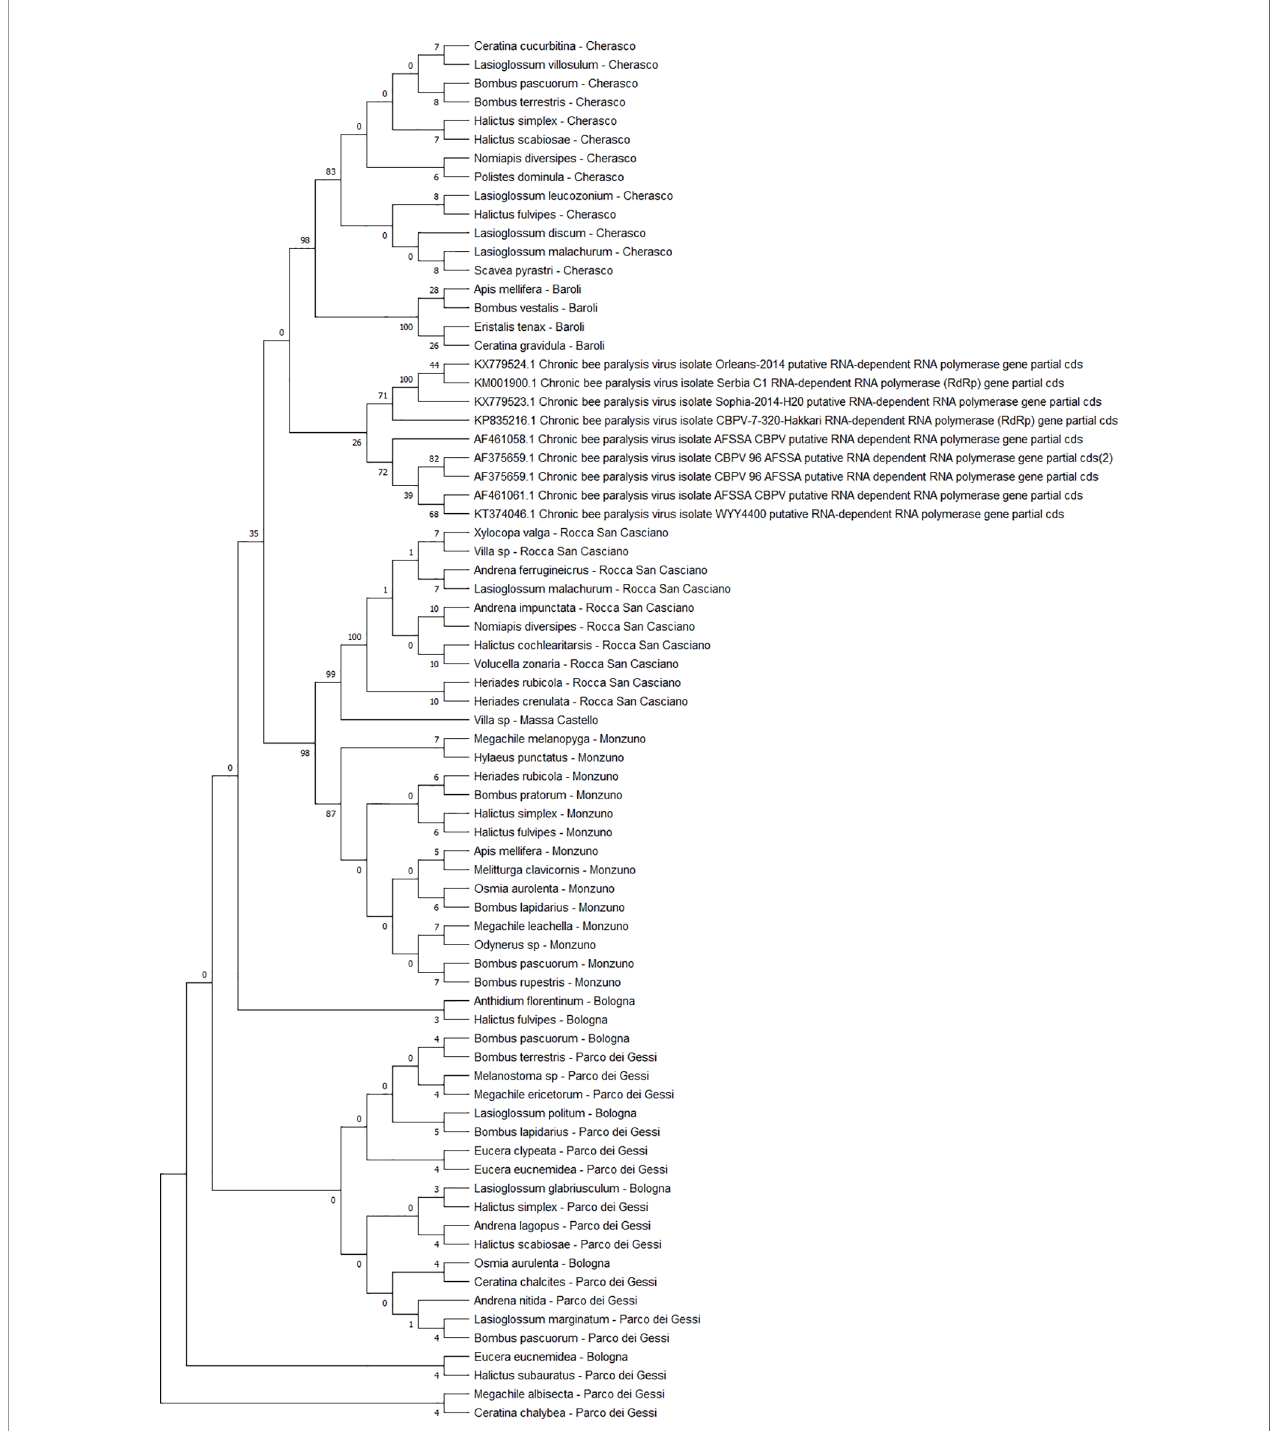
FIGURE 7 | Maximum likelihood nucleotide phylogeny of CBPV RNA-dependent RNA-polymerase gene. This analysis involved 74 nucleotide sequences. There were a total of 583 positions in the fi nal dataset. Only those with bootstrap > 50% are reported. Species and sampling sites are reported for the sequences identi fi ed in this study. CBPV, chronic bee paralysis